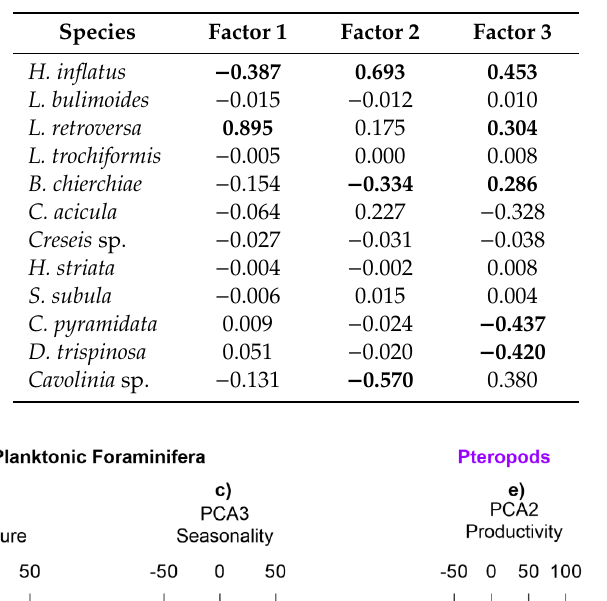
Table 5. Ranking of the pteropod species and their factor loadings along the PCA factors in core KIM-2A. Bold data indicate the most important factor loadings in each factor.